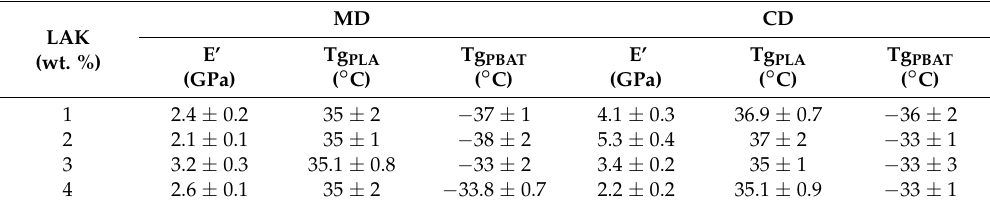
Table 4. DMTA results about blends based on PLA/EJ400/PBAT.